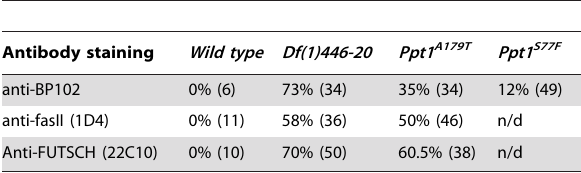
Table 3. Percentage of Ppt1 -deficient embryos displaying axonal defects.